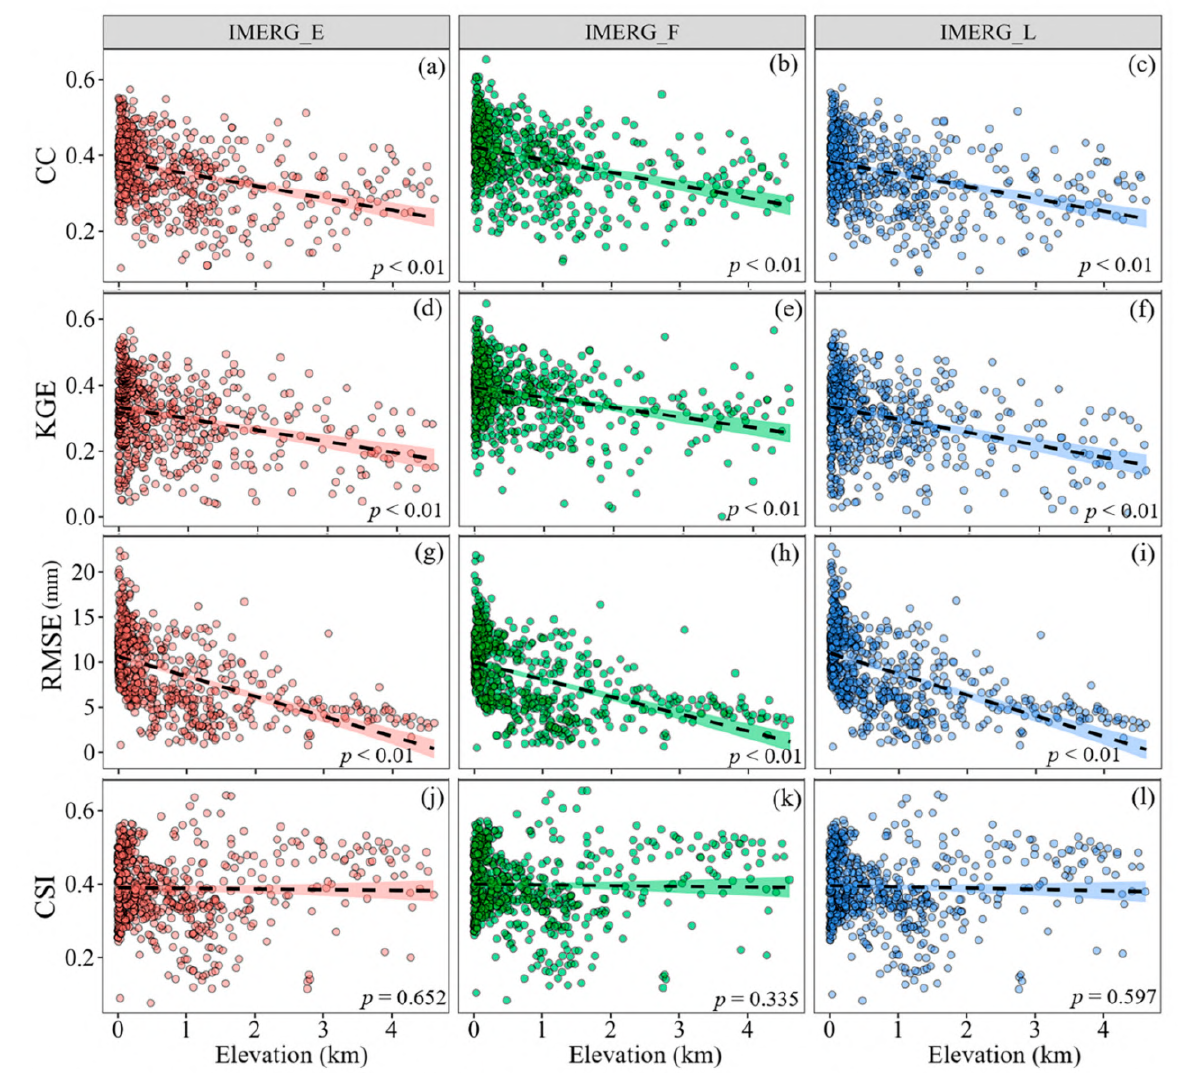
Figure 7. Relationship between calculated CC ( a – c ), KGE ( d – f ), RMSE ( g – i ) and CSI ( j – l ) for IMERG_E (Column 1), IMERG_F (Column 2) and IMERG_L (Column 3) products and elevation at the daily scale during